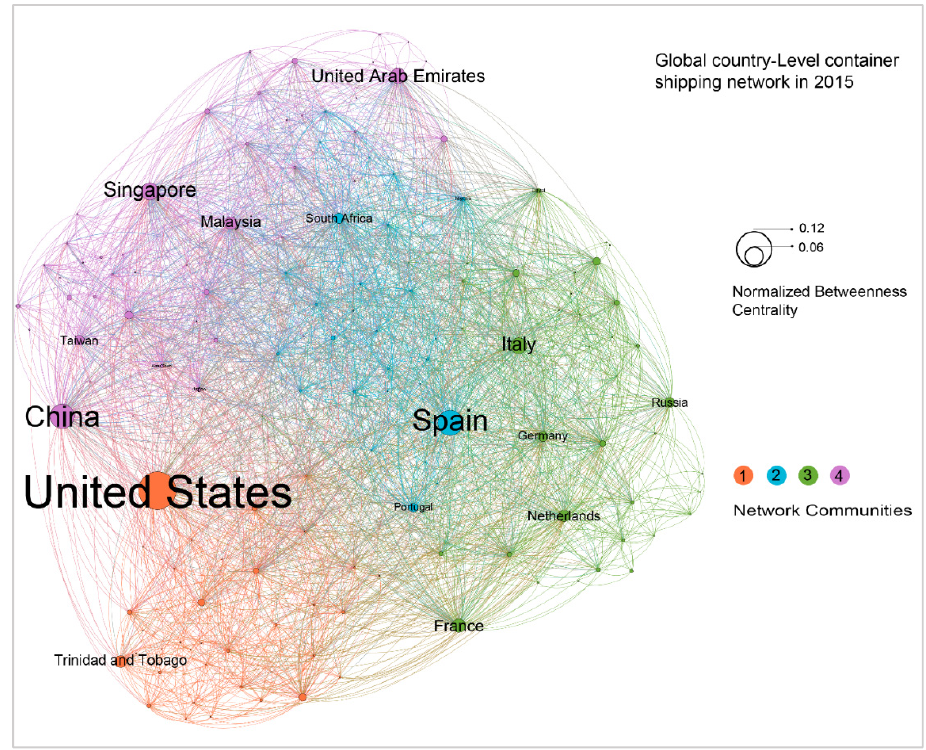
Figure 8. Global country-level container shipping network in 2015. A directed network with 2842 links and 150 countries. The size of a node refers the normalized betweenness centrality of a given node. The color refers to the four community clusters of the network. The color of a link is equal to the color of its departure node.